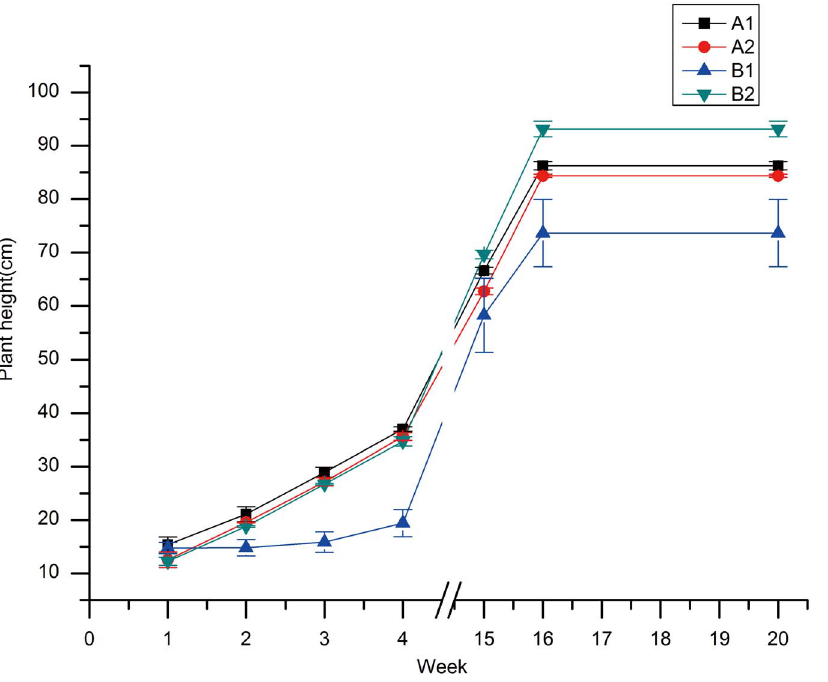
Figure 8. Treatment with 5 mmol Gd-DTPA in different growth media. The plant height was altered at different growth periods. The growth media included sandy soil and paddy soil. A1 and B1 represent sandy soil and paddy soil treated with Gd-DTPA, and A2 and B2 represent untreated sandy soil and paddy soil, respectively. which were bound together, and inserted into a 5 mm NMR tube